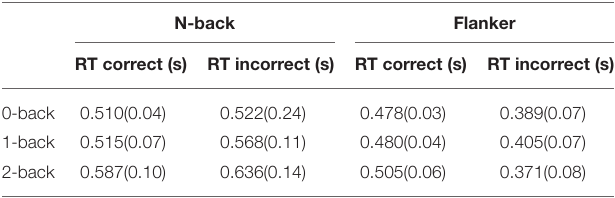
TABLE 3 | Mean value and standard deviation of reaction times (RTs) on correct and incorrect responses. N-back